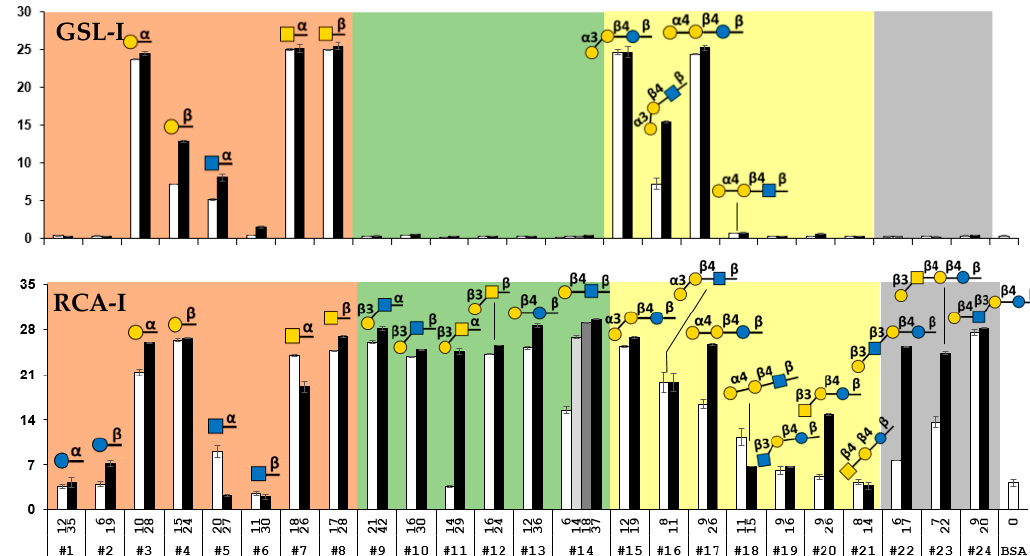
Figure 2. Binding profiles of six plant lectins including AIA, PNA, ECA, WFA GSL-I, and RCA-I studied using the glycan- BSA neoglycoprotein-immobilized bead suspension multiplex array. The glycan numbers (# 1 –# 24 ) shown on the bottom X-axis correspond to the glycans shown in Table S1. The values shown above the glycan numbers in the X-axis represent the average numbers of glycans per BSA molecule in the glycan-BSA conjugate. The fluorescence intensity results shown in bars represent the mean ± standard deviation of duplicates.